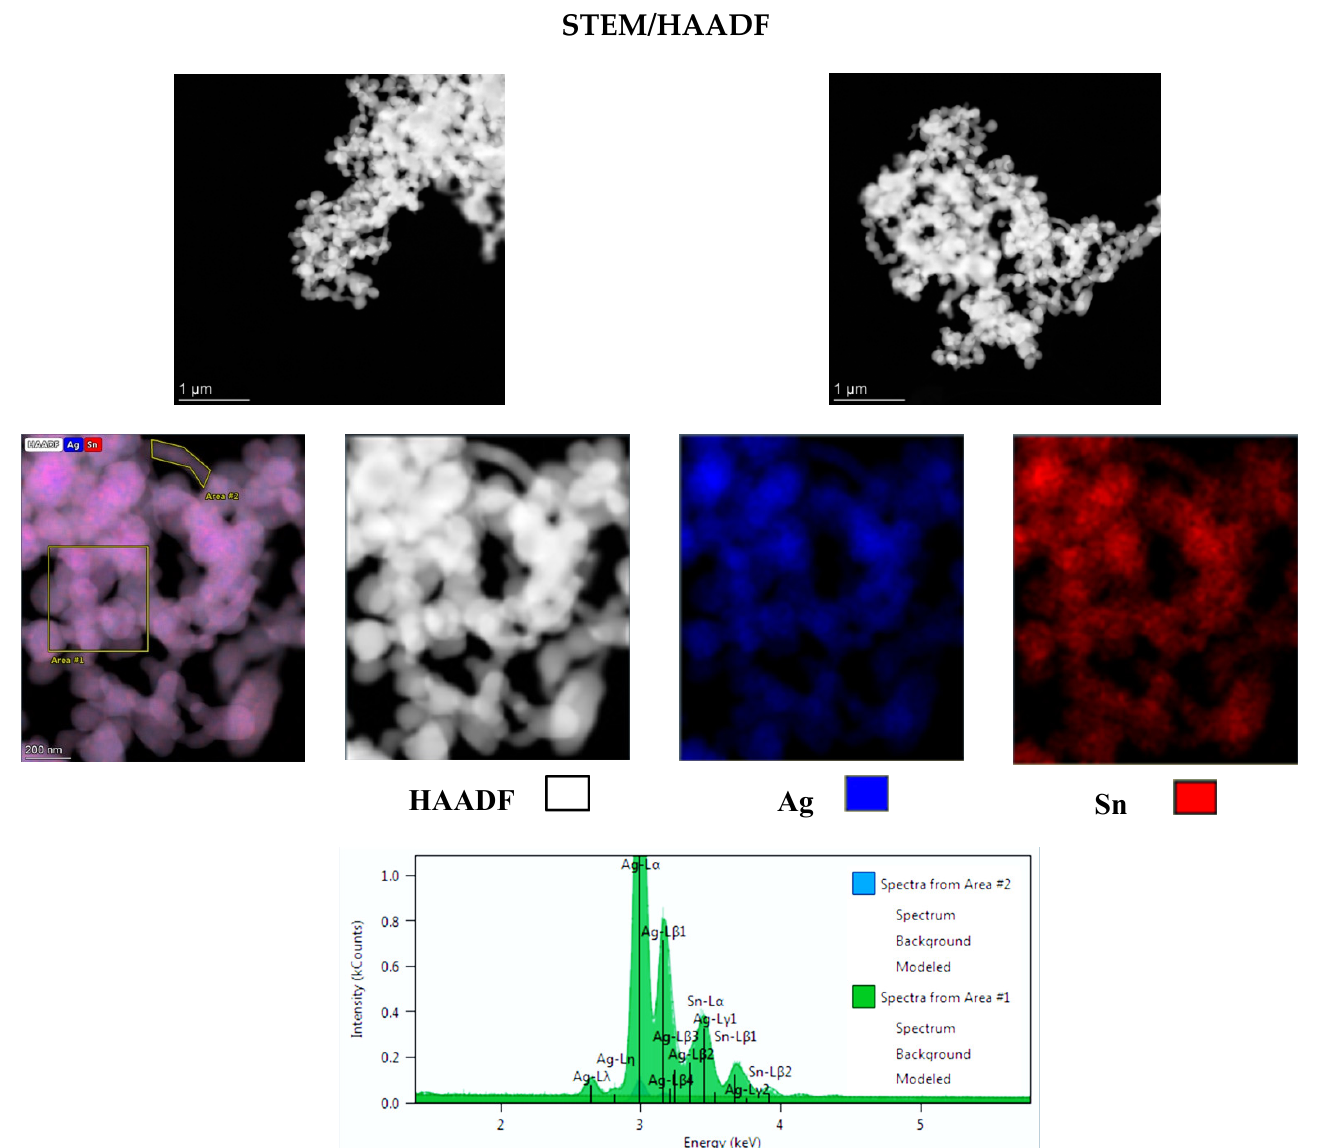
Figure 3. TEM images of Ag 5 Sn 0.9 particles and elemental analysis. Table 2. Quantitative analysis of areas 1 and 2.